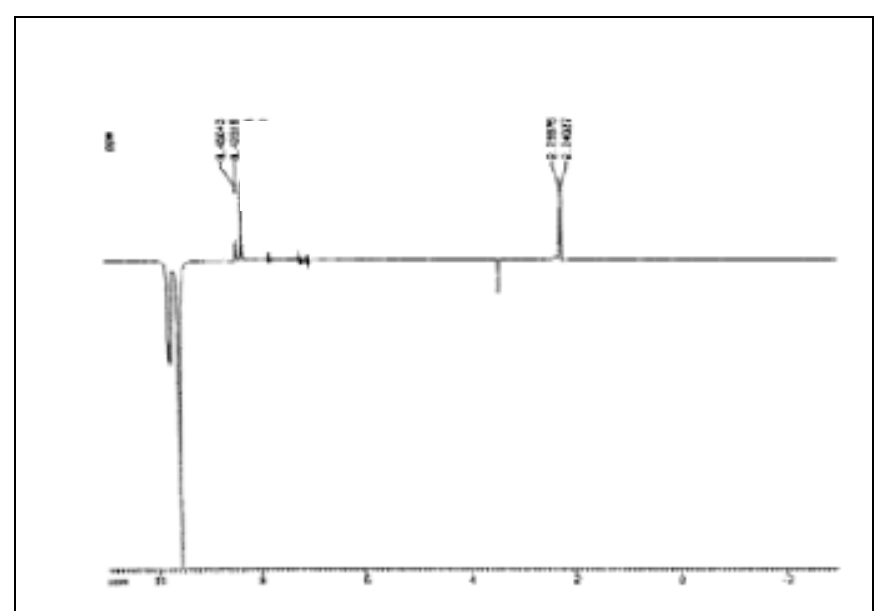
Figure 3. NOE Experiment on 2